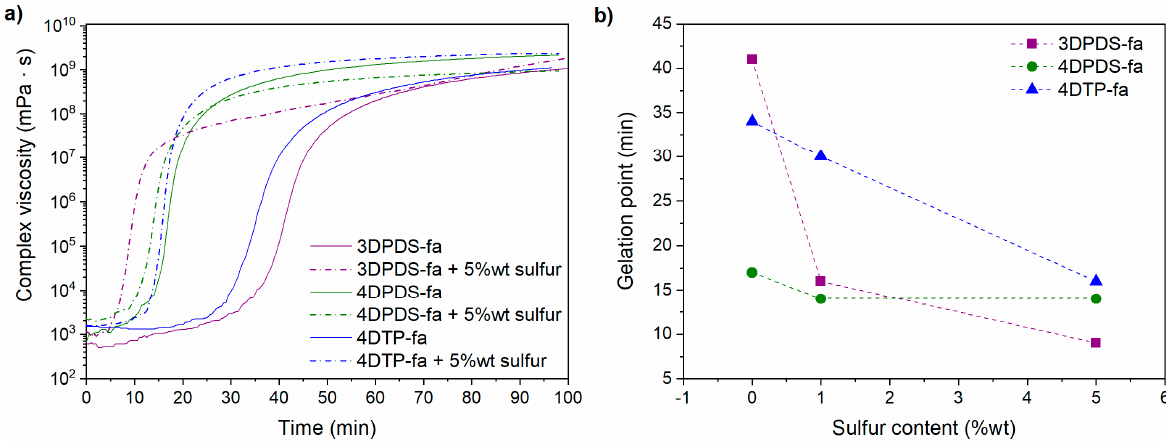
Figure 5. ( a ) Curing behavior of 3DPDS-fa, 4DPDS-fa, and 4DTP-fa without and with 5 %wt of sulfur by rheo-kinetics measurement at 150 °C followed by complex viscosity over time; ( b ) Gelation times of 3DPDS-fa, 4DPDS-fa, and 4DTP-fa as a function of sulfur content. Dash lines are drawn to guide the eye.